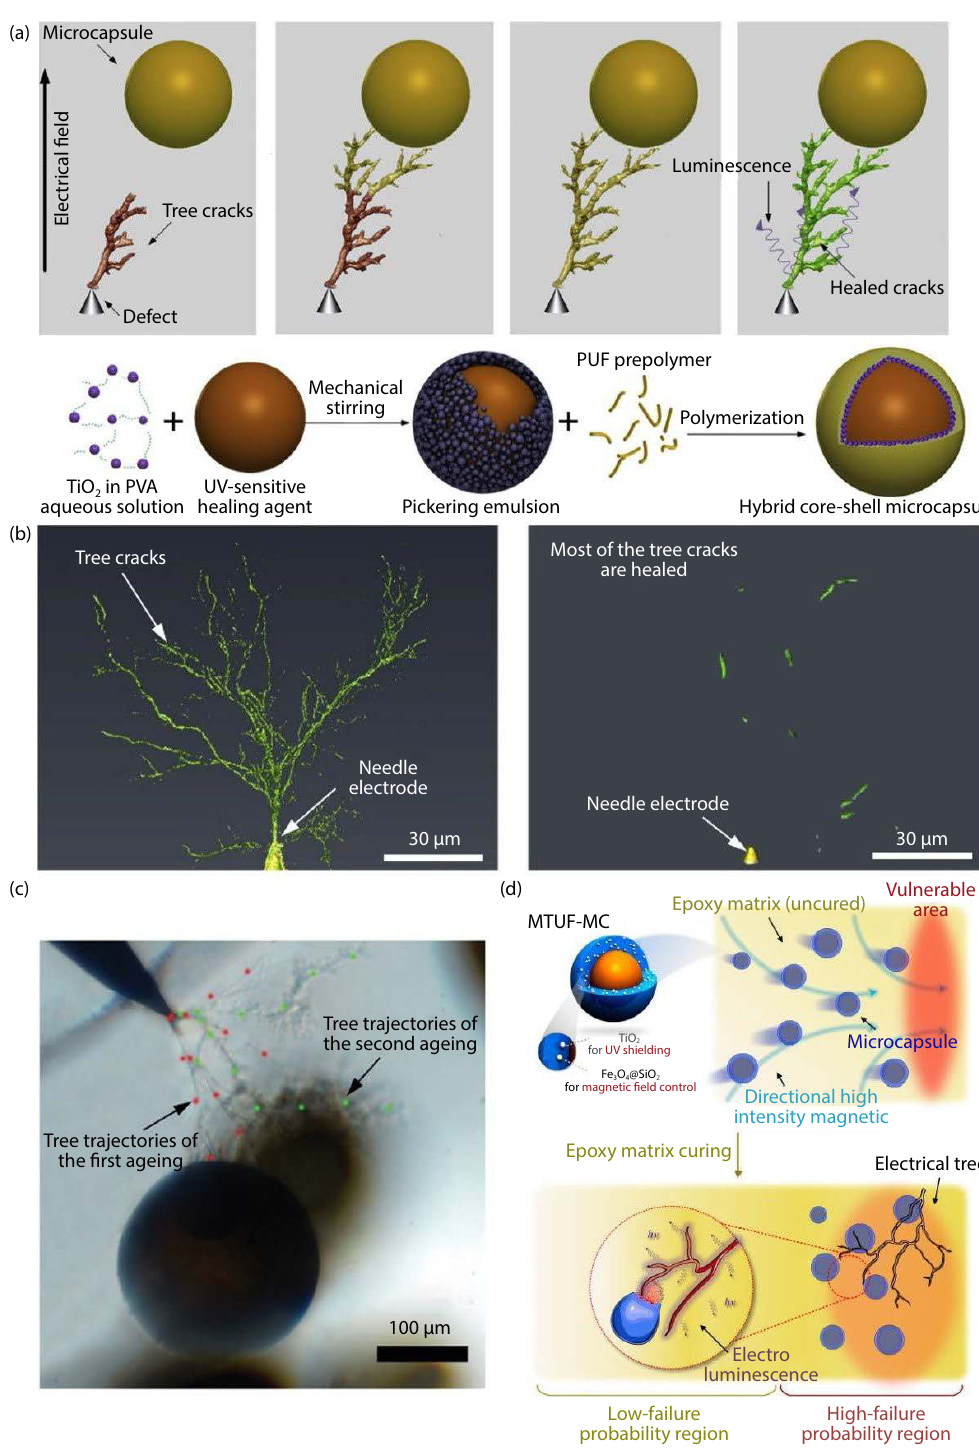
Fig. 18 Microcapsule-based self-healing insulating materials triggered by environmental stimuli. ( a ) The self-healing mechanism using polymerization is triggered by UV light during the electrical treeing process and the preparation of microcapsules. TiO 2 nanoparticles in capsule shells serve as light-absorbing materials (reprinted with permission from ref. [55], © 2019 Elsevier). ( b ) The reconstruction of electrical trees and healed trees in epoxy by computed tomography (reprinted with permission from ref. [55], © 2019 Elsevier). ( c ) Electrical trees developed in new paths in re-treeing process rather than along the trajectories of the first aging phase (reproduced with permission from ref. [55], © 2019 Elsevier). ( d ) Schematic of UV-triggered self-healing method with magnetic targeting. The microcapsules can be guided towards regions with higher electrical stress and failure possibility during manufacturing (reprinted with permission from ref. [232], © 2021 American Chemical